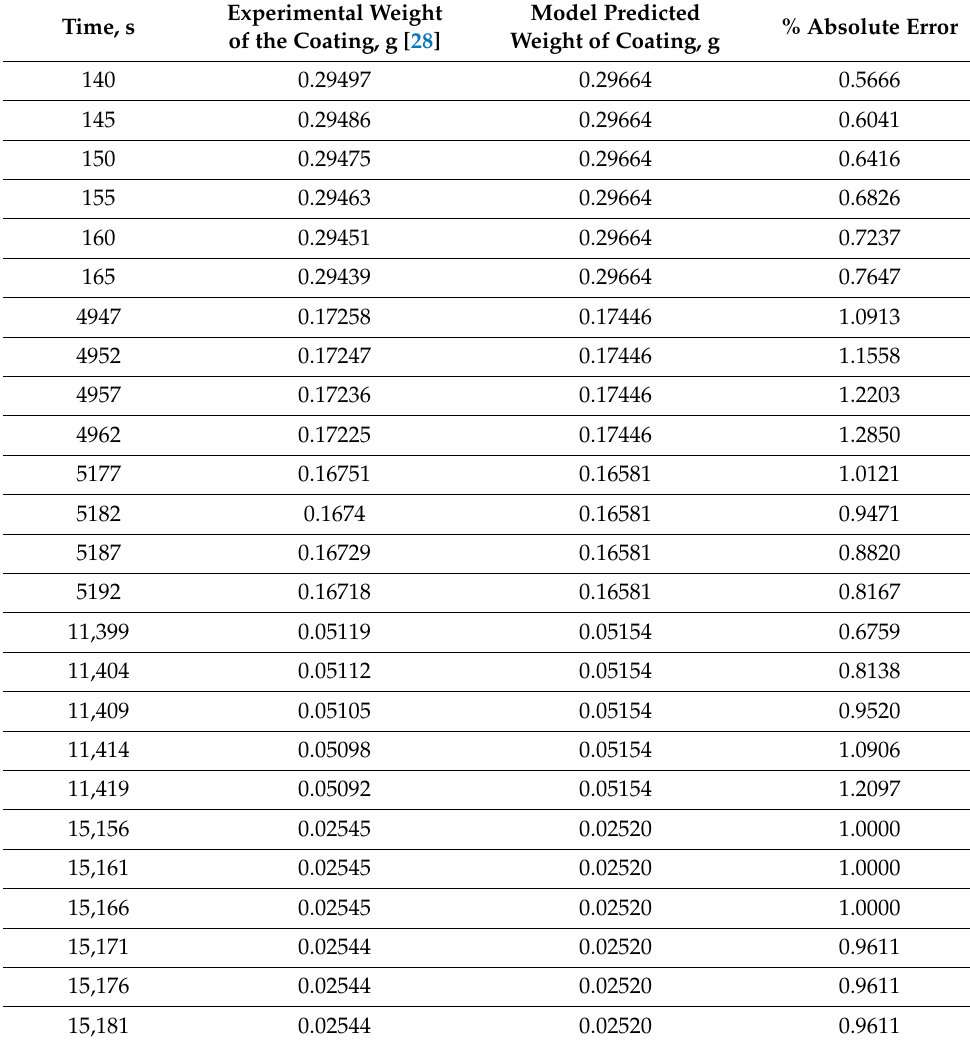
Table 3. Sample error between predicted and experimental values for 1999 µ m initial coating thickness with poly(styrene), p -xylene, and TPP contents of 5.03%, 93.95%, and 1.02%, respectively.